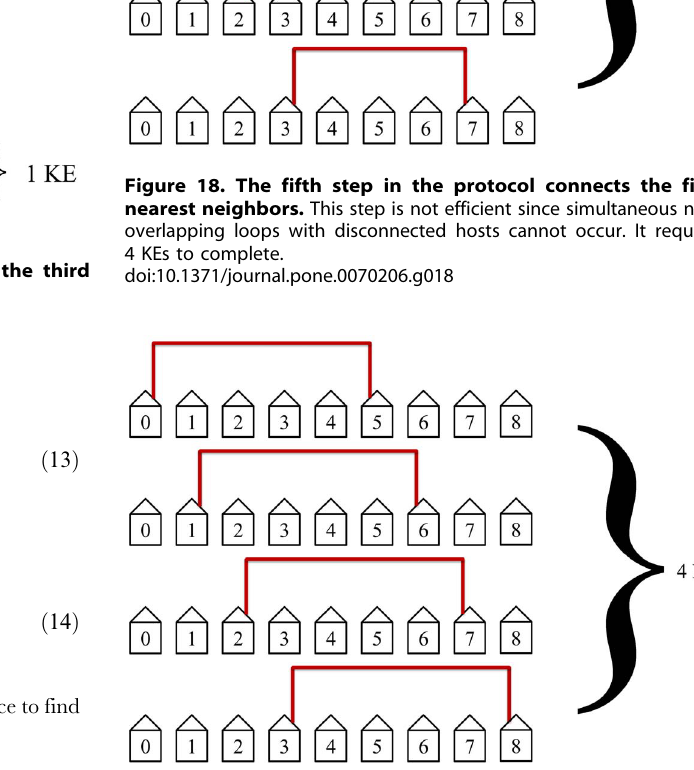
Figure 15. The second step in the protocol connects the second nearest neighbors. This step requires 2 KEs to complete.